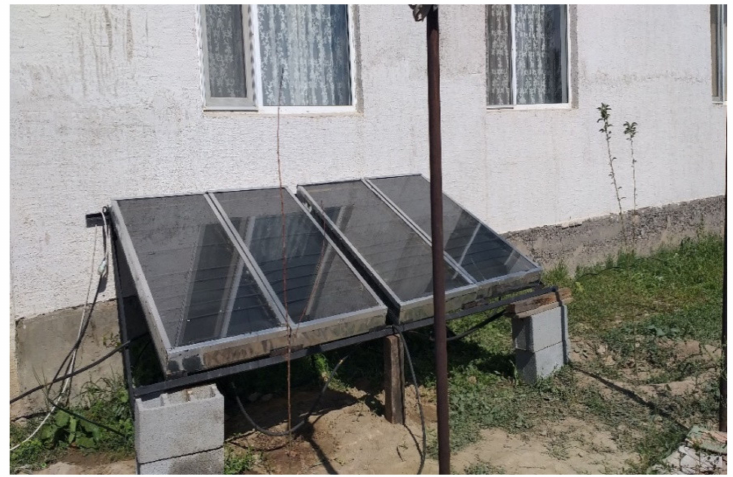
Figure 3. Layout of the heat collector.